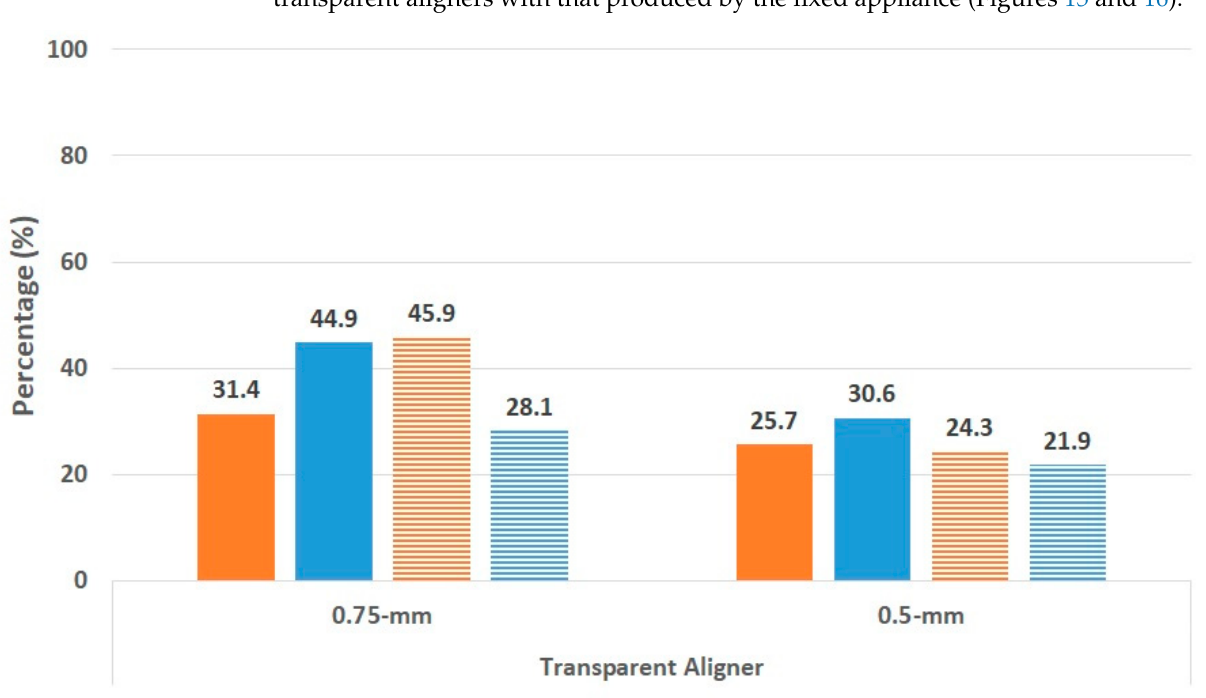
Figure 15. Principle stress of the periodontal ligament induced by the transparent aligner as compared to that induced by the fixed appliance.